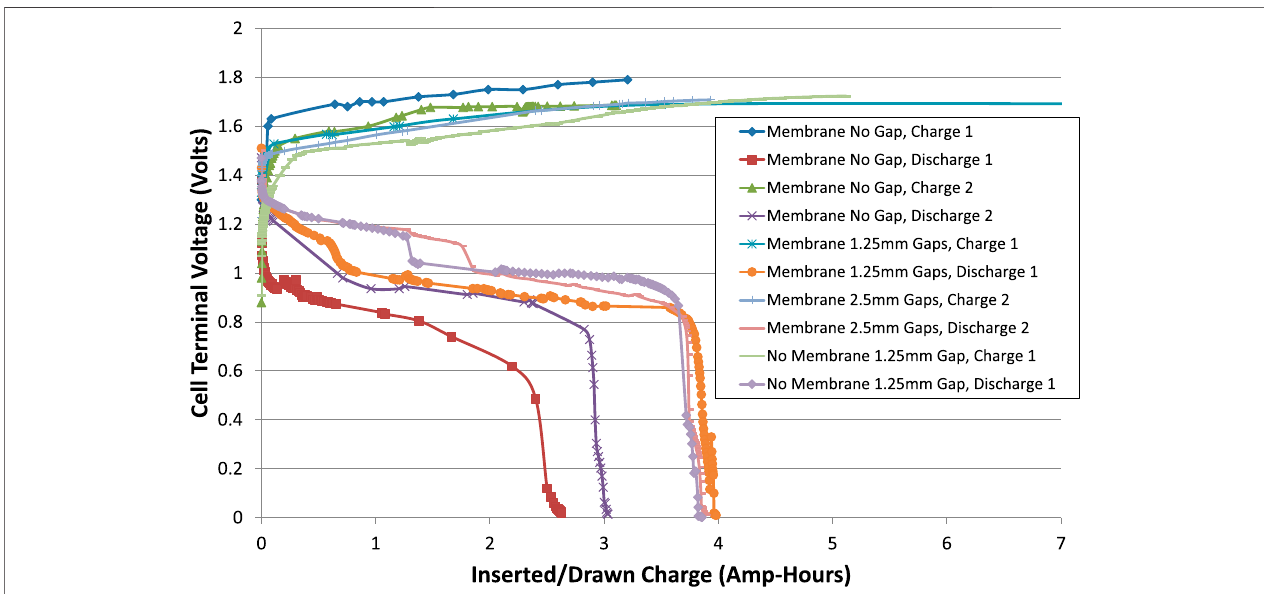
FIGURE4| Cellvoltagesduringchargeanddischargeexcludinginterruptions. Thecurrentwas ± 0.6 A(C/5rate)andthecelltemperature wasroomtemperature, about 20 ° C.